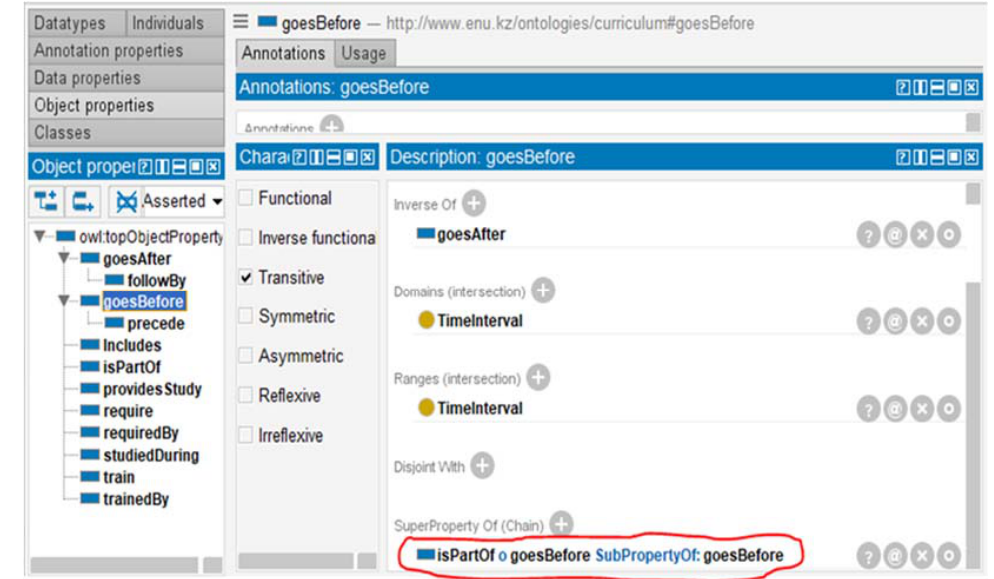
Figure 4. Definition of the Object Properties chain for the connection of AcademicYear and Semester in